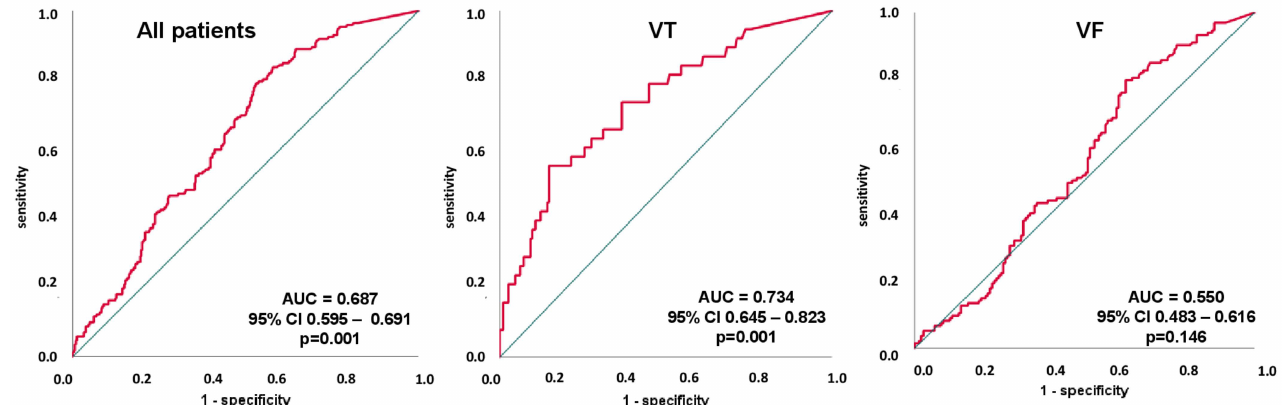
Figure 8. Receiver operator characteristic (ROC) curve analyses of cTNI for the prediction of 30-day all-cause mortality, stratified by patients within the entire study cohort, as well as separated by VT and